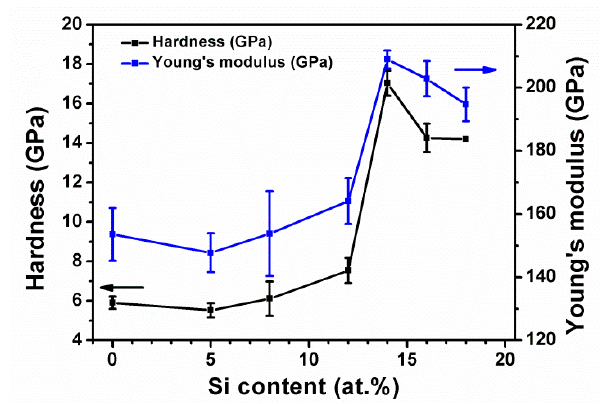
Figure 6. Hardness and Young’s modulus values of Cr–Si–N coatings with different silicon contents.